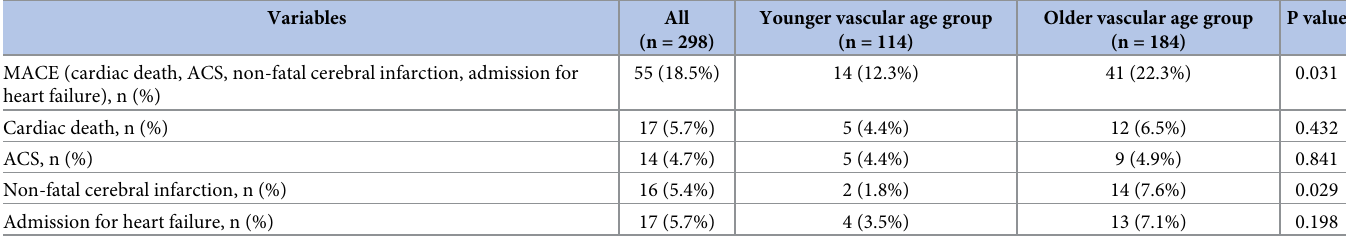
Table 3. Comparison of clinical outcomes between the younger vascular age group and older vascular age group.